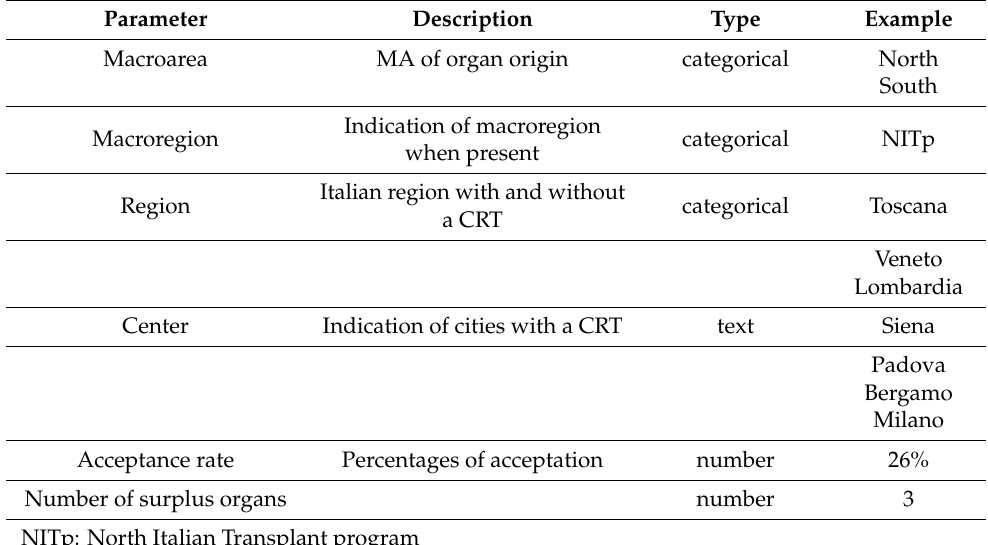
Table 2. List of parameters required by the app for the calculation of both probability models: (1) The probability for the n-lung to be offered and accepted and (2) the probability that at least an n-th lung will be offered and